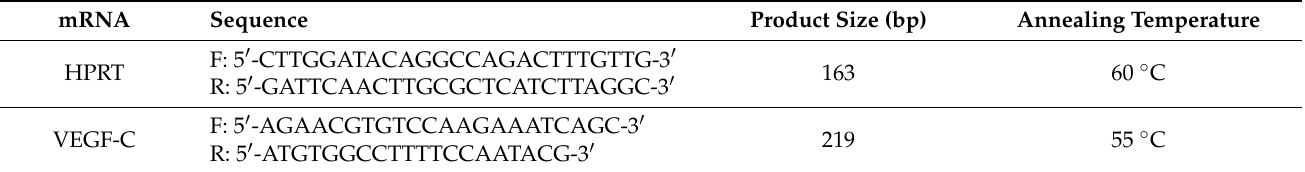
Table 1. RT-PCR primer (F = forward primer, R = reverse primer, VEGF = vascular endothelial growth factor, HPRT = hypoxianthine-guanine